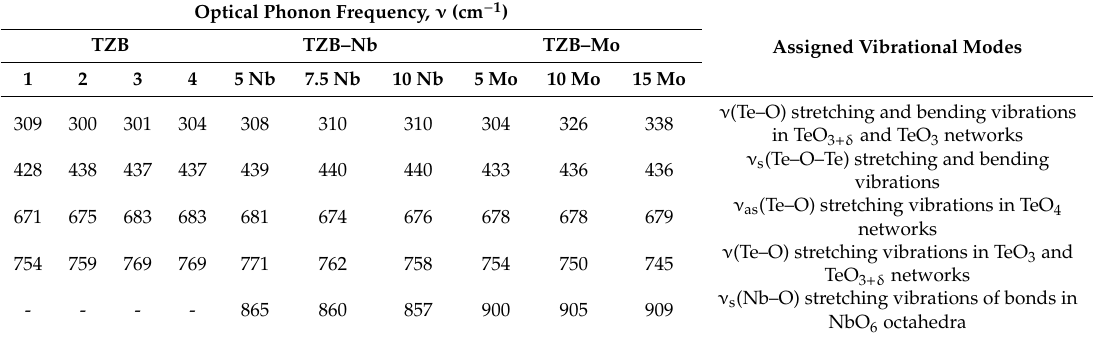
Figure 2. ( A – C ) Raman spectra of TZB, TZB − Nb and TZB − Mo glass systems and ( D – F ) Deconvoluted Table 2. Raman bands’ frequency and their assignment in the TZB series glass system for different modifier contents.